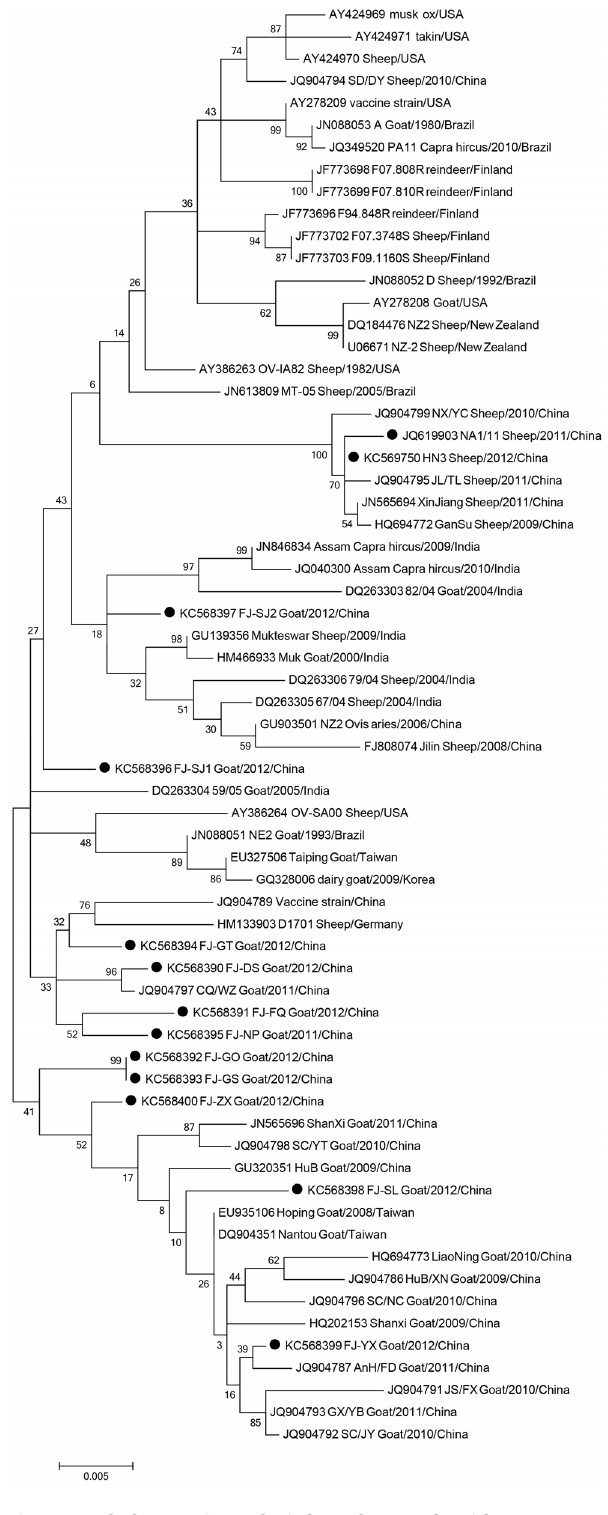
Figure 6. Phylogenetic analysis based on nucleotide sequences of ORFV011. The phylogenetic relationship was constructed by the Maximum Likelihood Method using MEGA 5.0 software. Black circles: 11 different orf isolates from Fujian Province (China) and two orf isolates from other provinces.